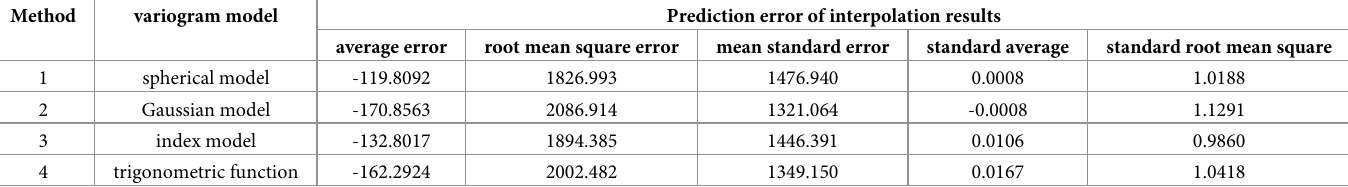
Table 1. Comparison of the results of different interpolation